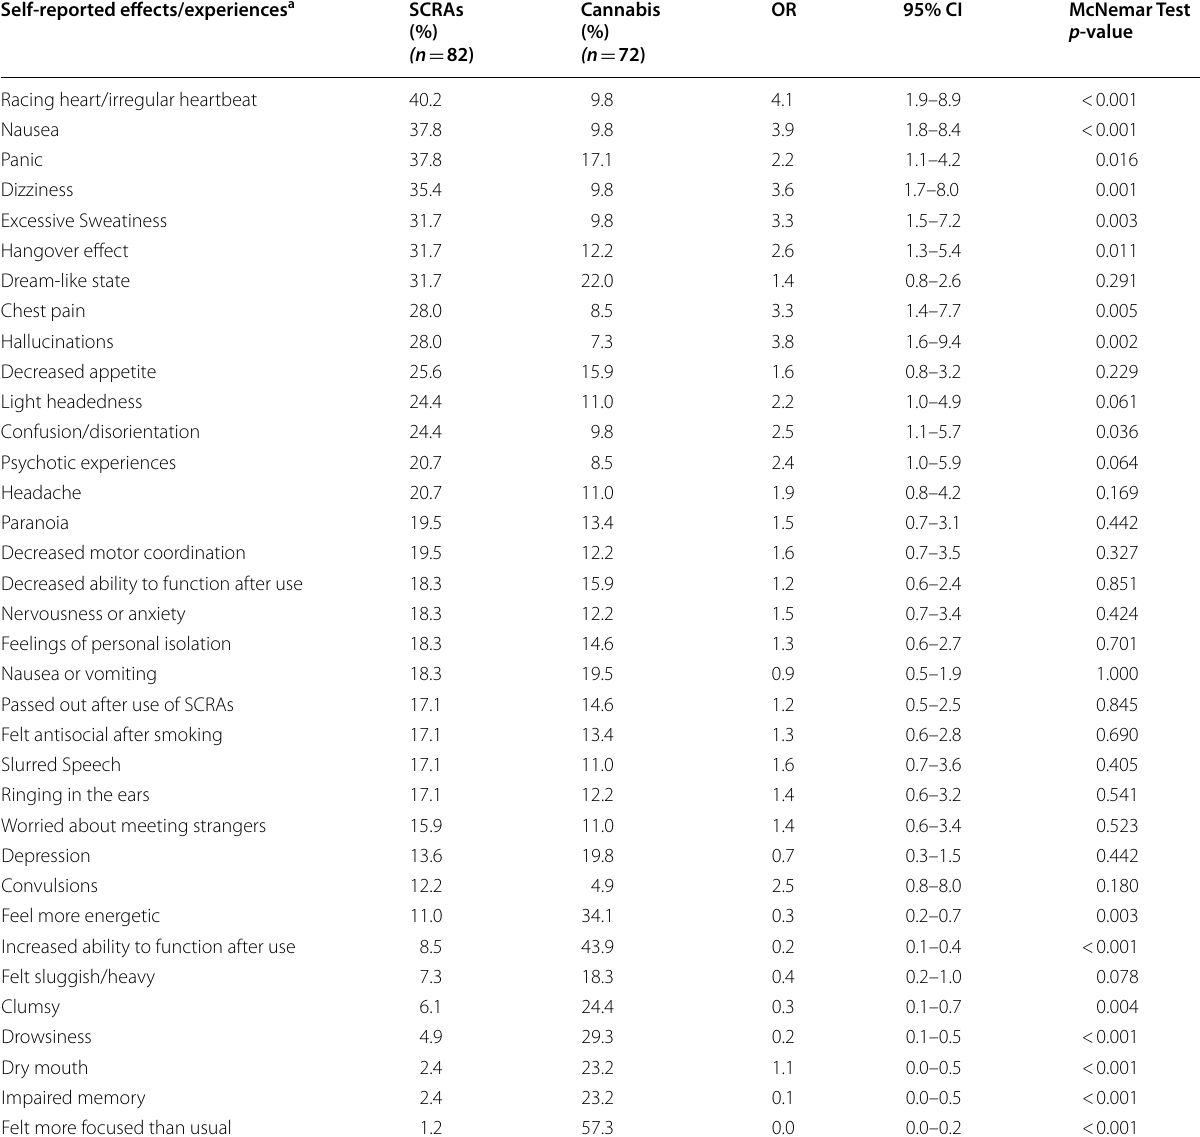
Table 4 Comparison of effects of SCRA and cannabis use as reported by 154 participants undergoing treatment for cannabis use